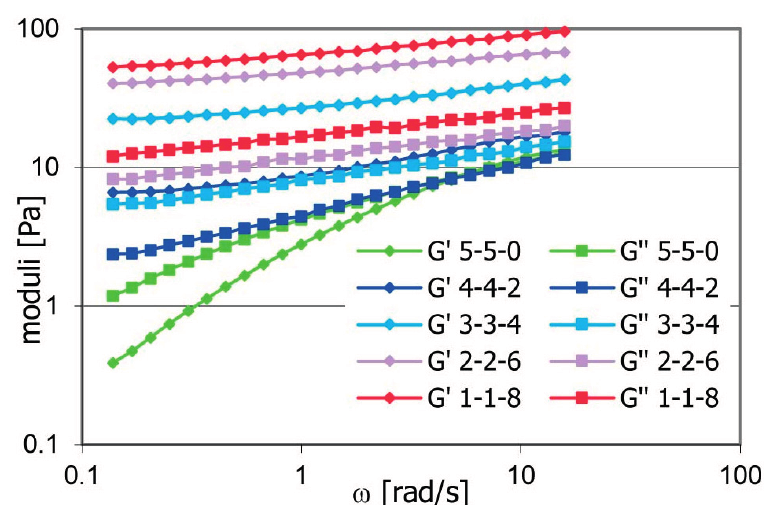
Figure 8. G’, G’’ trends as a function of the frequency of ternary gels prepared with T-HB-A at different ratios (1% w / w